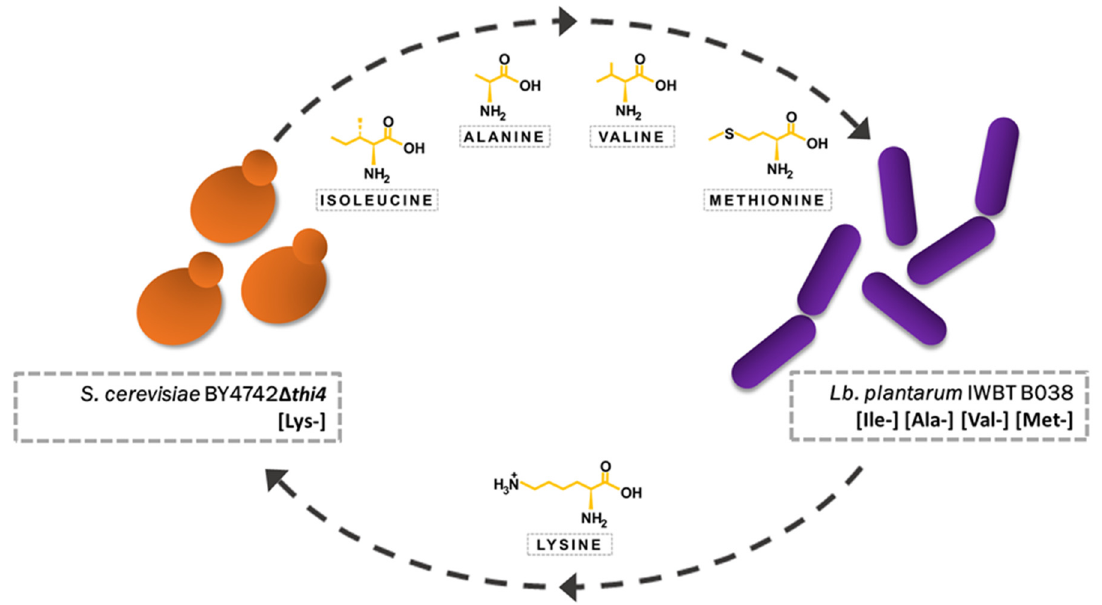
Figure 1. In the established synthetic mutualism S. cerevisiae strain BY4742 Δ thi4 and Lb. plantarum strain IWBT B038 provide their partner with the required amino acids omitted from their external environment.